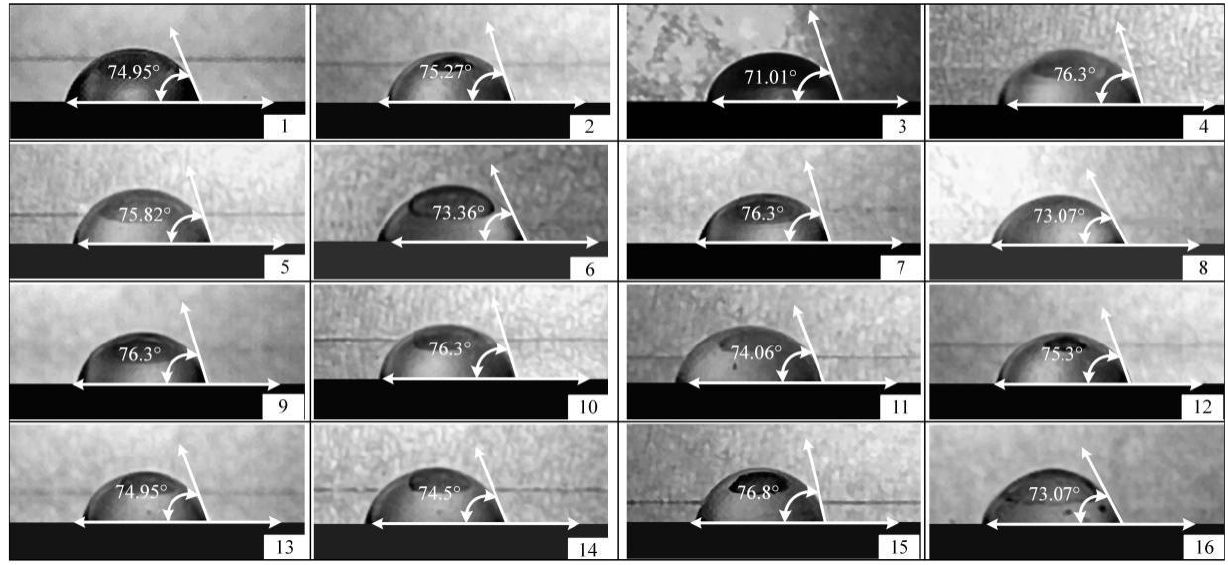
Figure 1. Contact angles of mixed hydrogels on stainless steel plates at different solution temperatures, gelatin concentrations, and alginate concentrations ( n = 16). When the concentration of gelatin was 6 wt%, the concentration of sodium alginate was 7 wt%, and the solution temperature was 65 ◦ C; the contact angle of the mixed hydrogel was the smallest. The minimum value is 71.01 ◦ (Groups 3). The contact angles of the mixed hydrogels were maximal when the gelatin concentration was 7 wt%, the sodium alginate concentration was 8wt%, and the solution temperature was 45 ◦ C. The maximum is 76.8 ◦ (Groups